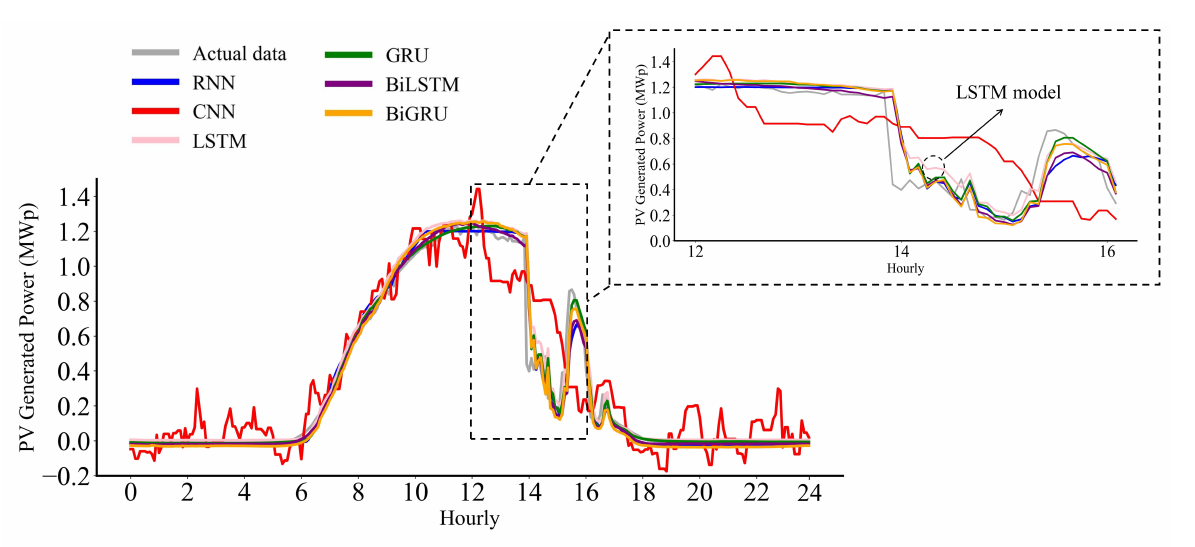
Figure 9. One-day PV generation forecasting on a cloudy weather day obtained by a single model and compared with actual PV generation data. The inset figure shows the forecasting performance of the single model between 12 and 16 h. In the single deep learning model, the most preferable model for short-term prediction of PV power generation on a cloudy weather day is the LSTM model.